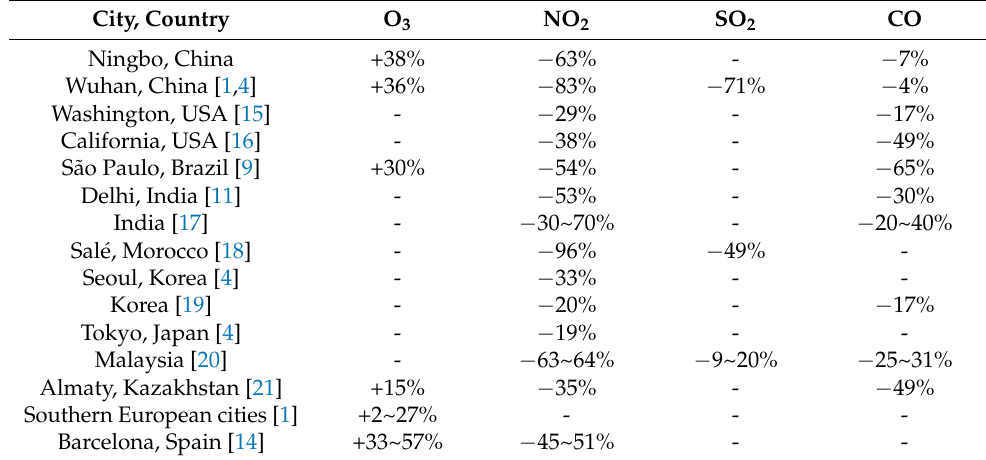
Table 1. Changes in air pollutants caused by lockdowns in cities or